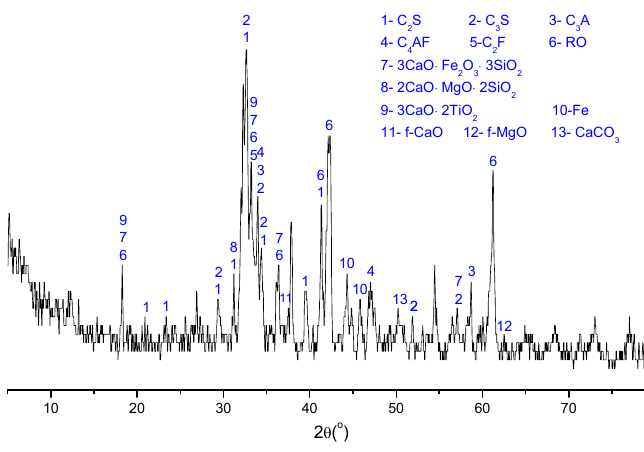
Figure 1. X ‐ ray diffraction (XRD) pattern of converter steel slag. Figure 1. X-ray diffraction (XRD) pattern of converter steel